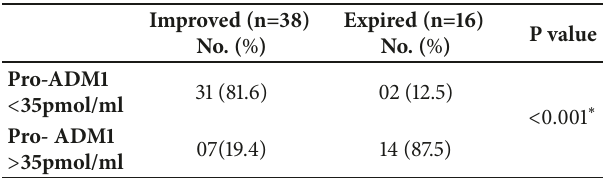
Table 4: Comparison of Pro-ADM1 with cut-off 35pmol/ml and outcome in the study